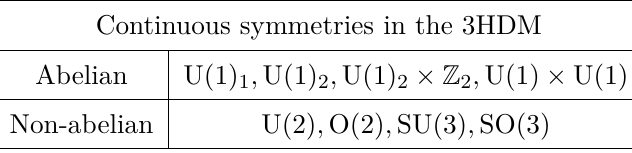
stands for the usual CP. 2